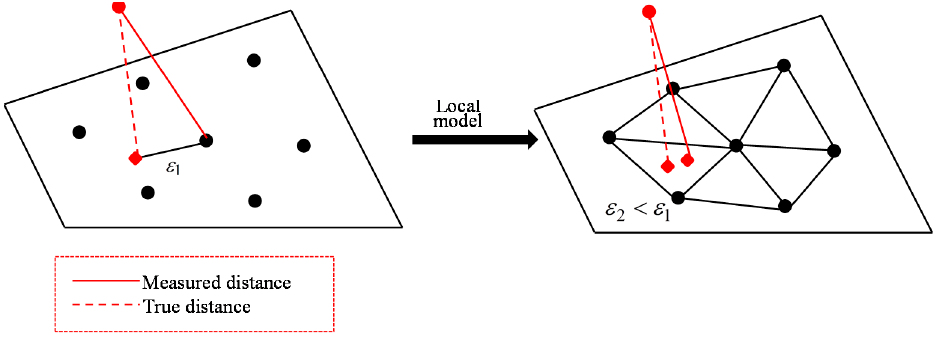
Figure 9. Local surface model for cloud-to-cloud distances.